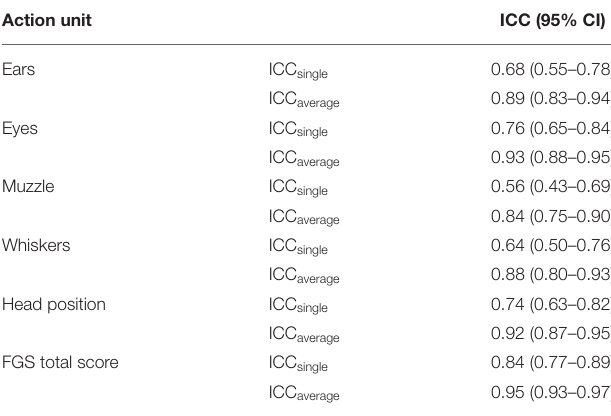
TABLE 1 | Inter-rater reliability of the Feline Grimace Scale in cats with oral disease. Action